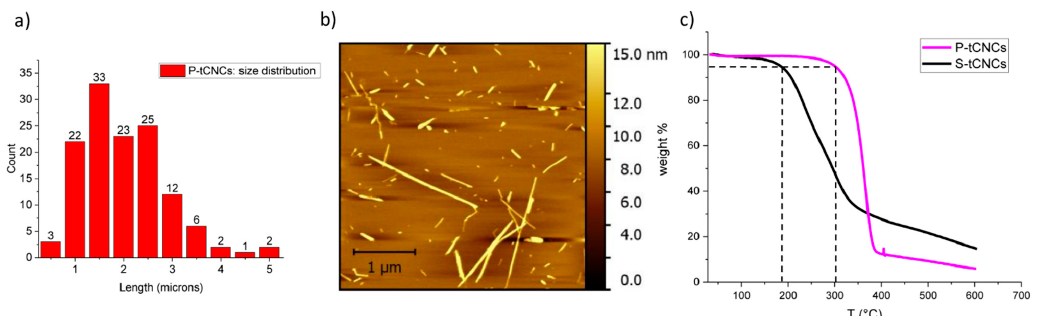
Figure 1. ( a ) P-tCNC size distribution, determined from atomic force microscopy (AFM) images, as the one shown in ( b ). ( c ) Thermogravimetric analysis (TGA) traces of cellulose nanocrystals (CNCs) extracted from tunicates cellulose with phosphoric acid (P-tCNCs, red) and sulfuric acid (S-tCNCs, black), showing the superior thermal stability of P-tCNCs with a degradation onset of 300 °C compared to 180 °C for S-tCNCs.